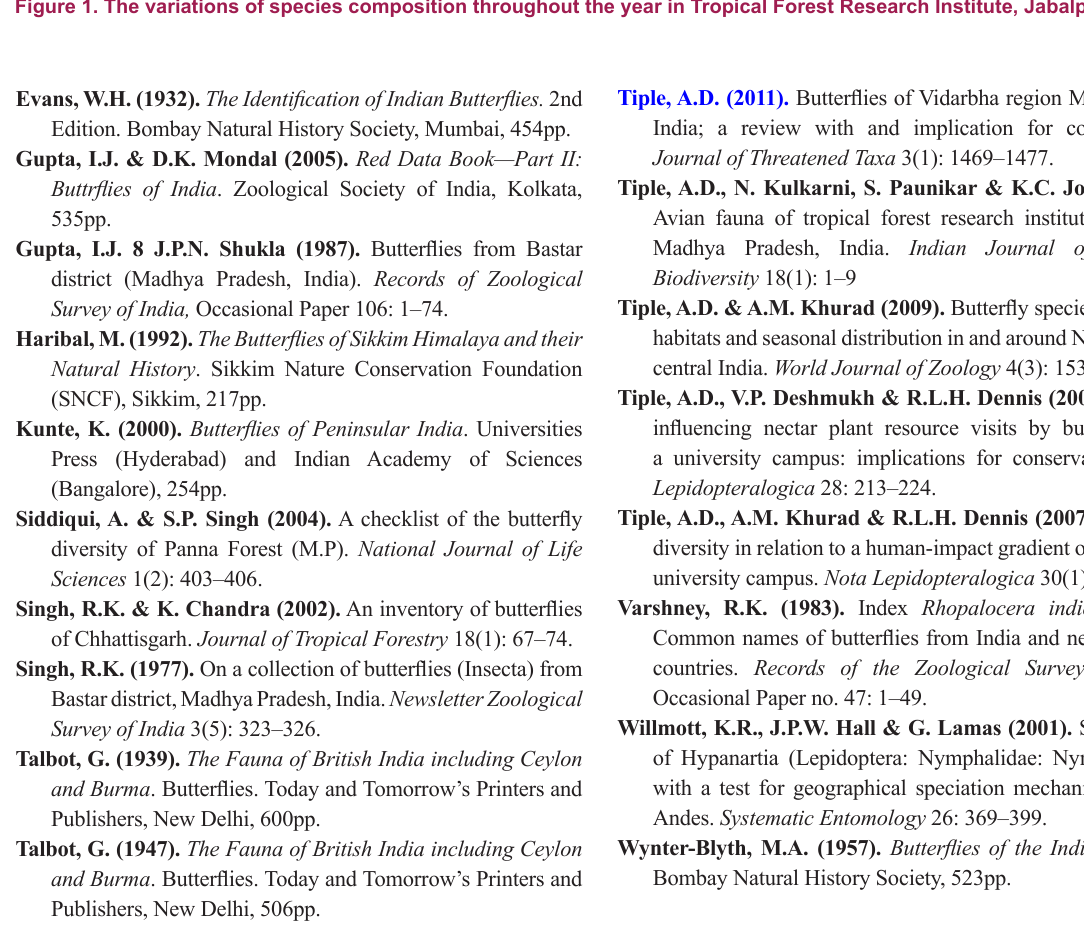
Figure 1. The variations of species composition throughout the year in Tropical Forest Research Institute, Jabalpur